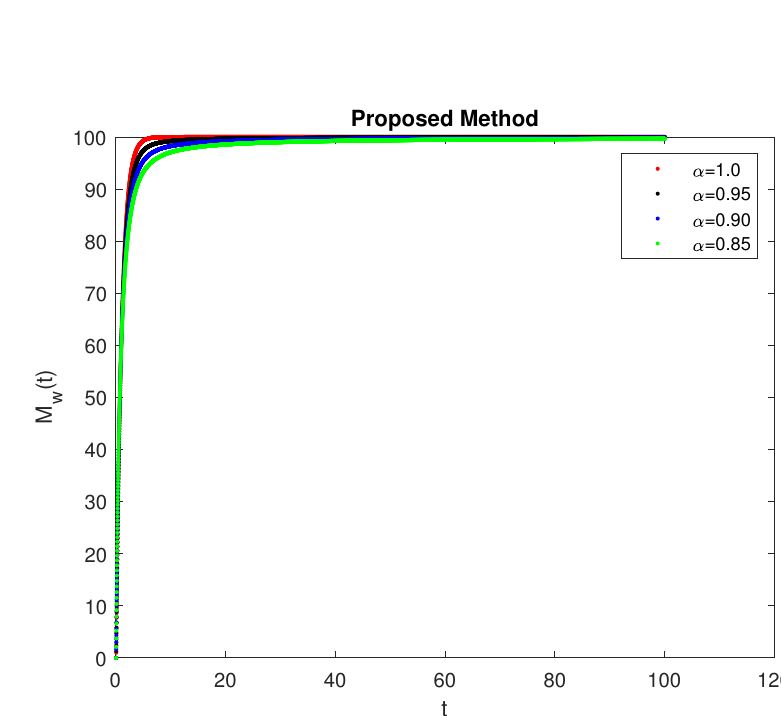
Figure 12: Numerical simulations for τ = 1 for Caputo